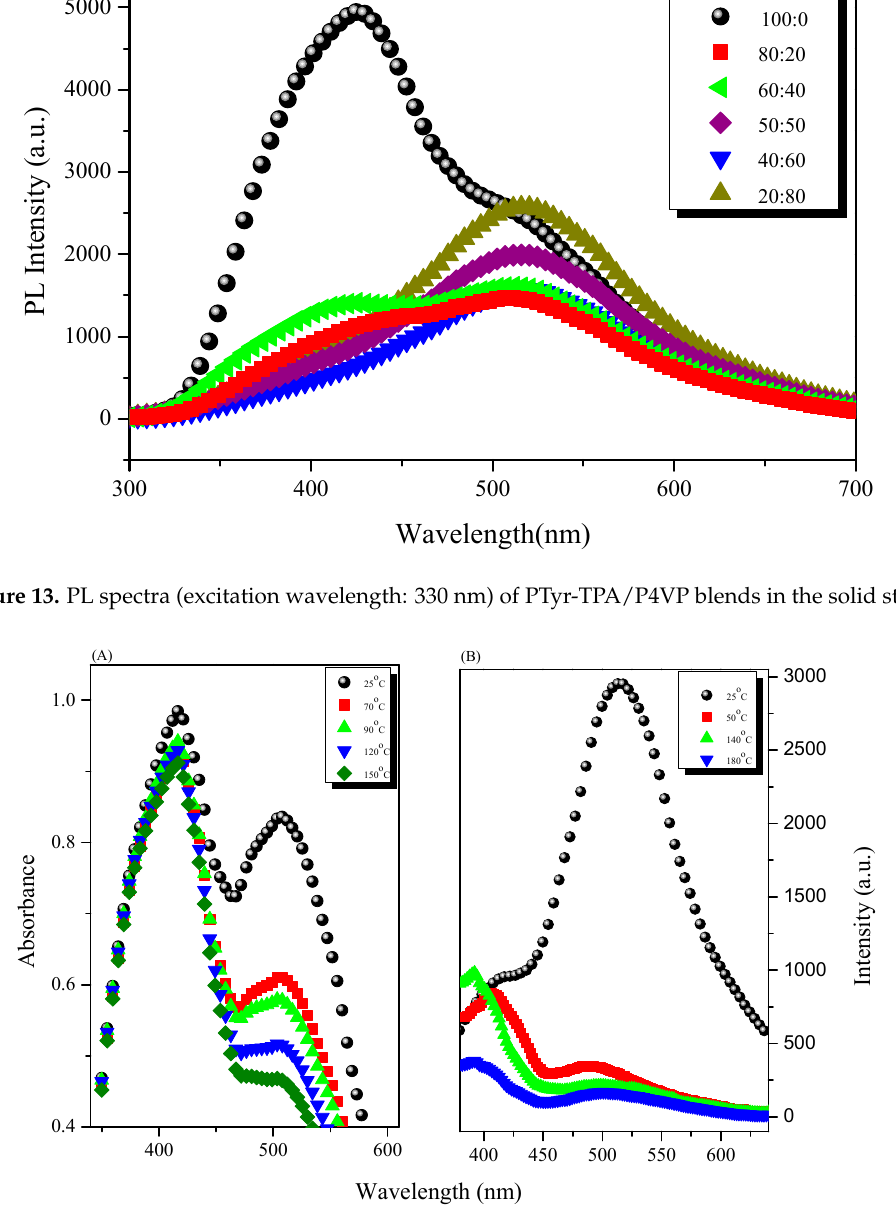
Figure 14. UV ( A ); and PL ( B ) spectra of the PTyr-TPA/P4VP = 20/80 blend in the solid state, recorded at various temperatures.